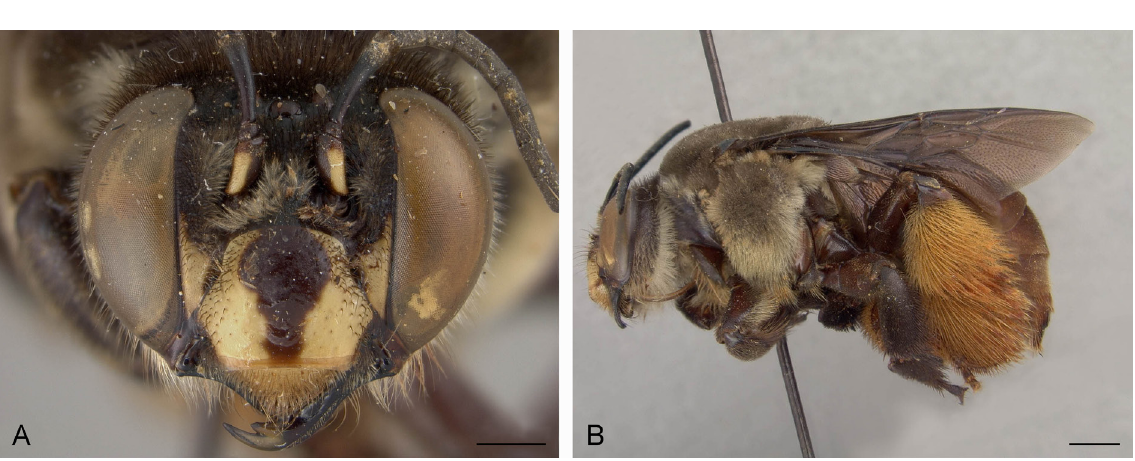
Fig. 1. Centris lilacina Cockerell, 1919, holotype, ♀ (NMNH; USNM ENT 00534201). A . Frontal view. B . Habitus, lateral view. Scale bars: A = 1 mm; B = 2